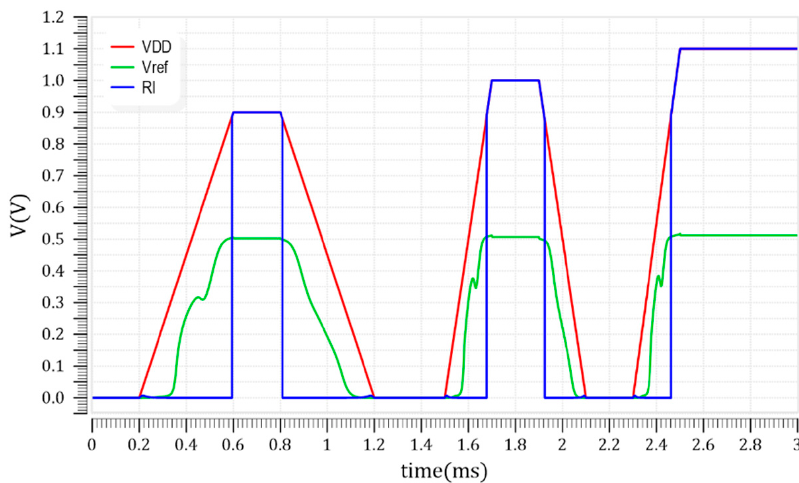
Figure 10. Simulation results for BGR#2 (65 nm, 1 V) in typical temperature (27 °C) and 1 V supply voltage, ±10%.